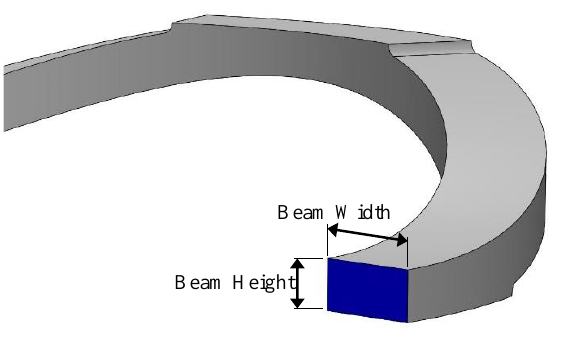
Figure 7. Beam aspect